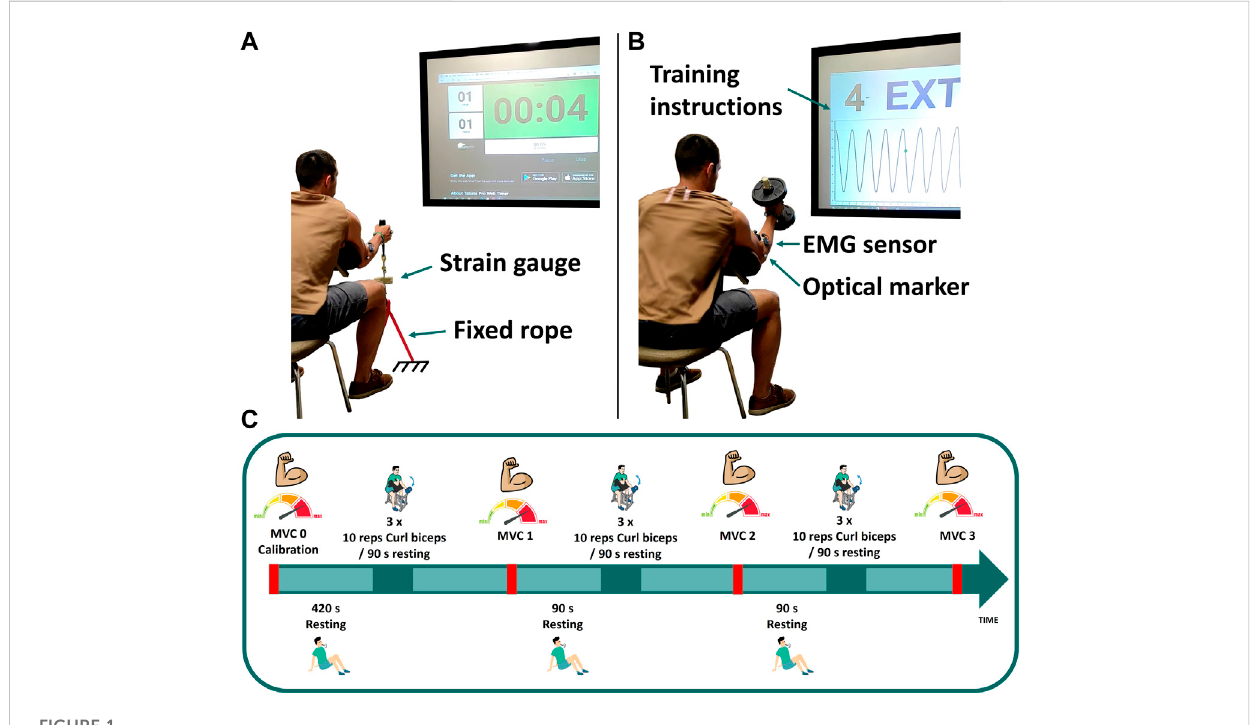
FIGURE 1 Experimental measurements: (A) maximum voluntary contraction; (B) dumbbell weightlifting; (C) schematic of the test protocol for visit